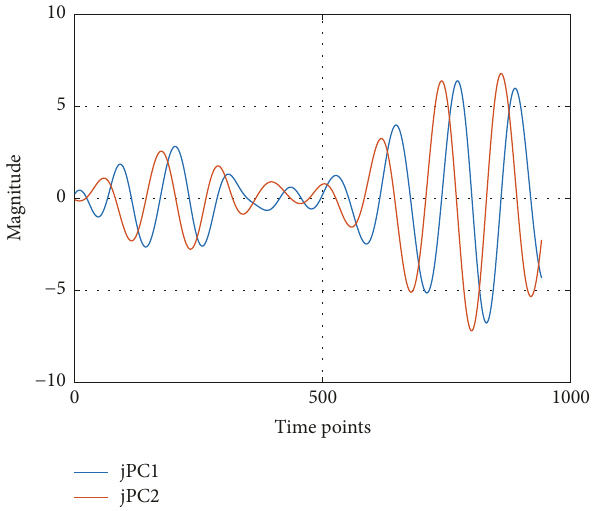
Figure 5: The projections (of the first subject in the young group) onto the two-dimensional jPCs versus time.